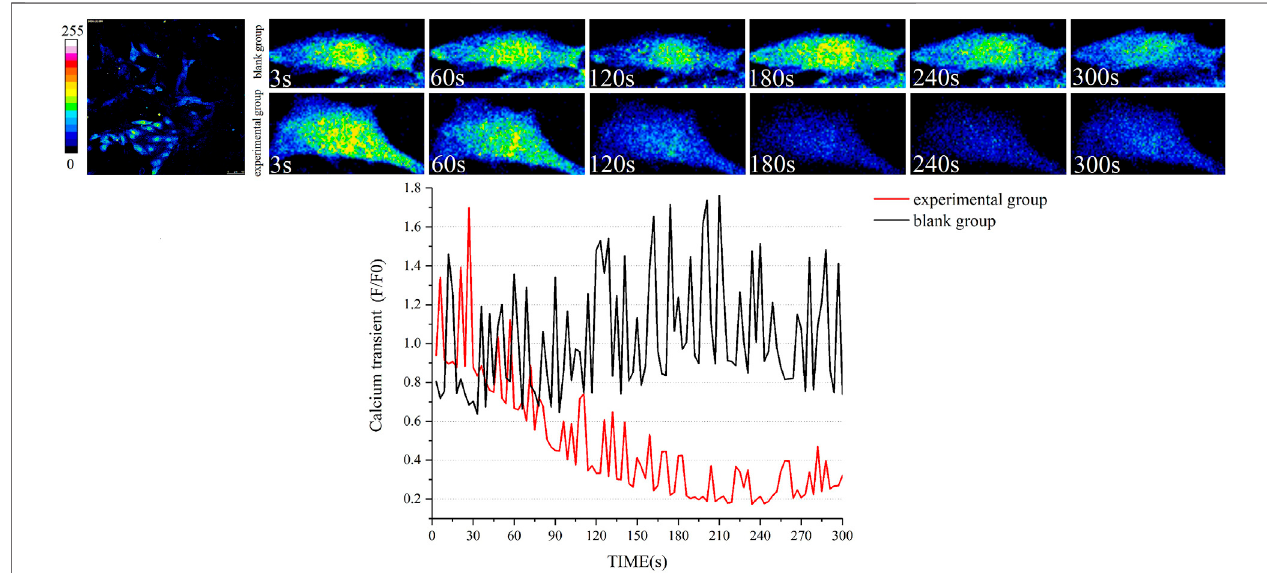
FIGURE8| EffectofWKoncytoplasmicCa 2+ transientincardiomyocytes.Blackline:Ca 2+ transientintheblankgroup;Redline:Ca 2+ transientintheexperimental group. n (cid:1) 5 myocardial cells for each group. General Linear Model with Greenhouse-Geisser tests was applied for comparisons. The Ca 2+ transient in the two groups was actually the same at baseline. However, after the infusion of high-dose WK, Ca 2+ transient signi fi cantly reduced in the experimental group.